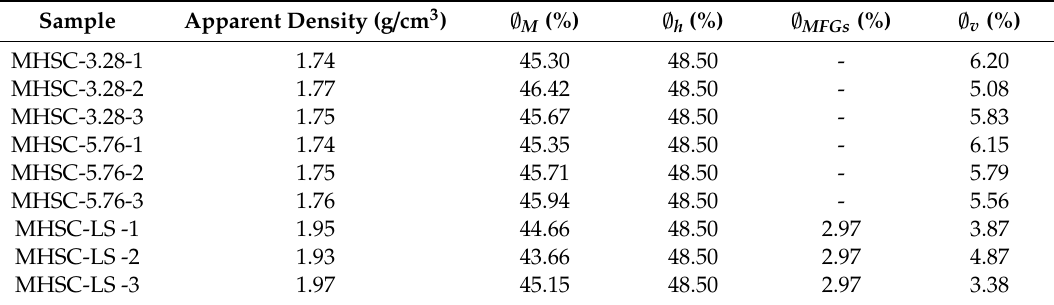
Table 3. The physical properties of the MHSCs.